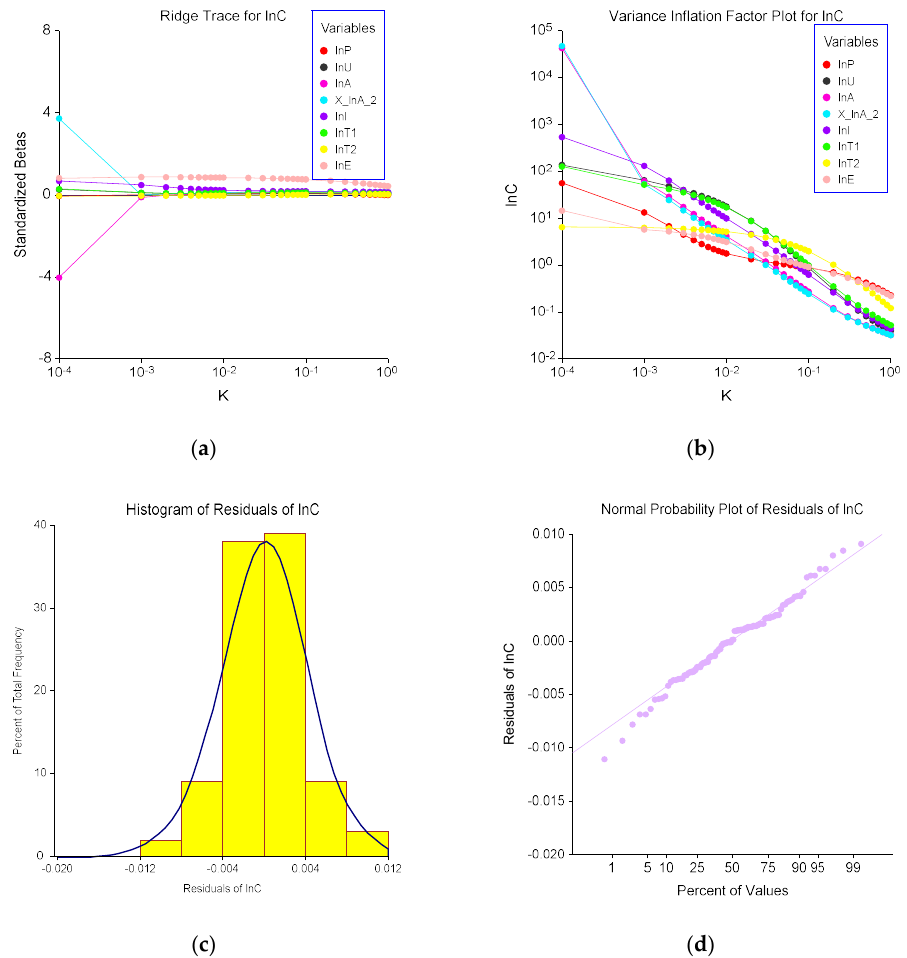
Figure 4. Ridge regression report. ( a ) Ridge trace for lnC, ( b ) variance inflation factor (VIF) plot for lnC, ( c ) histogram of lnC residuals, and ( d ) normal probability plot of lnC residuals. C: CO₂ emissions. lnC: the logarithmic form of C. Table 4. Analysis of variance for k = 0.1.